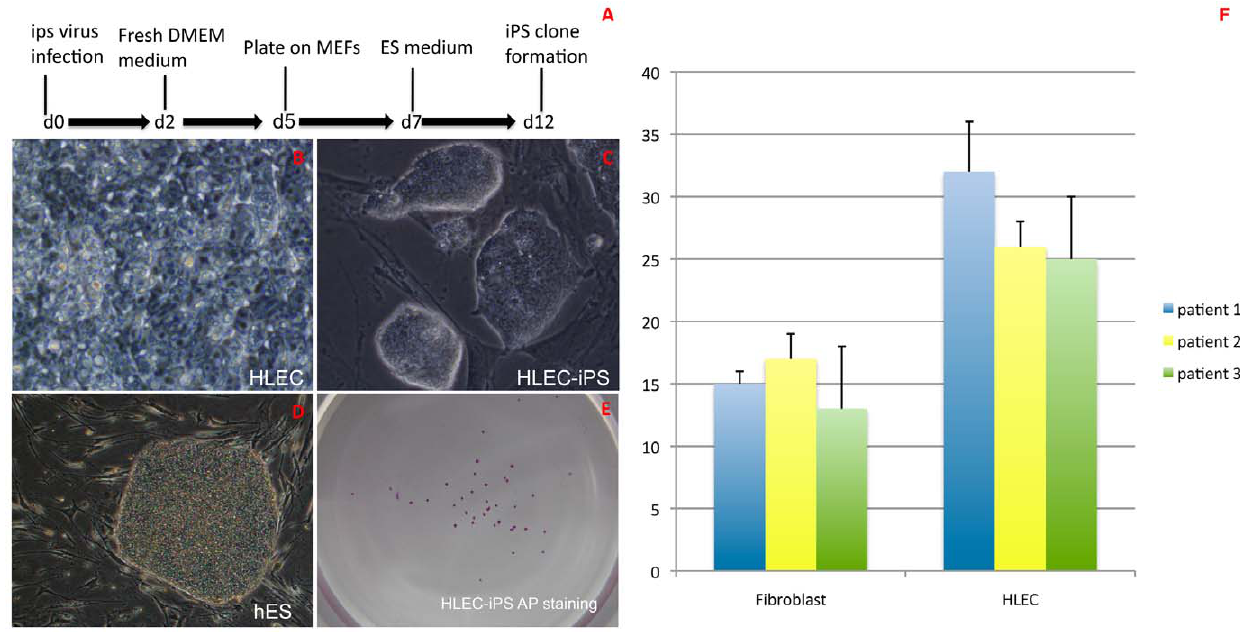
Figure 1. The derivation of induced pluripotent cells from HLECs. HLECs were infected with lentiviruses carrying DNA constructs encoding KLF-4, OCT-4 and SOX-2 to generate induced pluripotent stem cells (HLEC-iPS). (A) A schematic representation of the experimental strategy used to reprogram HLECs. (B) The infected HLECs were plated onto mouse embryonic fibroblasts (MEFs). Colonies with an ES cell-like morphology (C), which appeared as early as 12 days following infection, and (D) H9 ES cell lines. (E) HLEC-iPSCs express pluripotency markers alkaline phosphatase (AP). (F) HLECs can be induced to iPSCs with high efficiency compared with human fibroblast cells: HLEC and human fibroblast cells were collected from three age-related cataract patients. After the iPS factors had been added for 14 days, AP staining was performed, revealing approximately 25 AP-positive clones from 1 6 10 6 HLEC cells and approximately 15 clones formed from 1 6 10 6 human fibroblast cells.